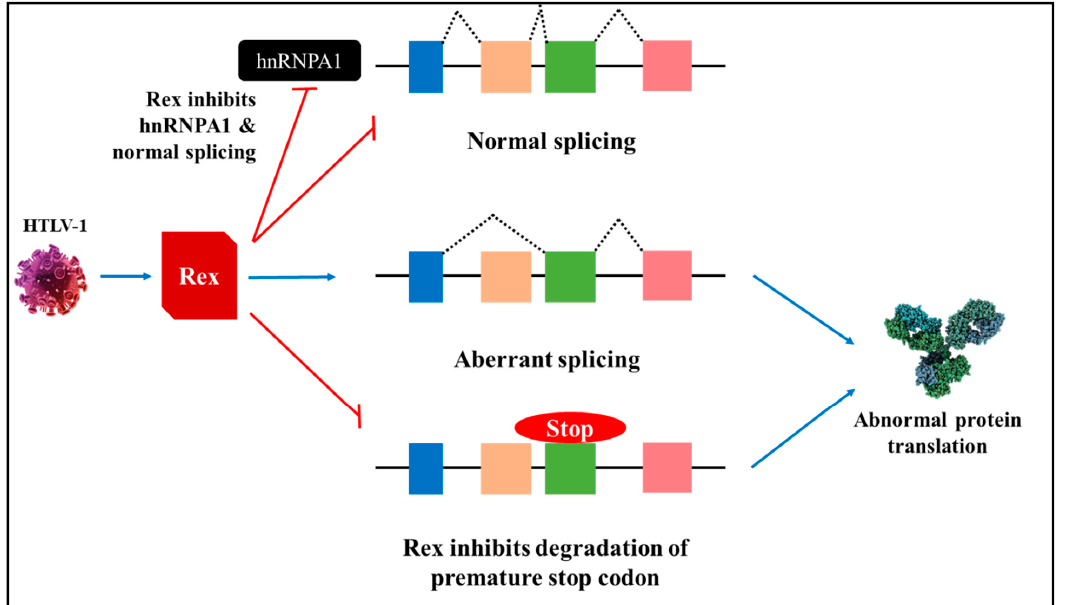
Figure 6. Rex-mediated splicing. Human T cell leukaemia virus 1 (HTLV-1) produced viral protein, Rex, suppresses hnRNPA1 to induce aberrant splicing and inhibit degradation of transcripts with a premature stop codon, thereby leading to abnormal protein translation. Red bars: suppression